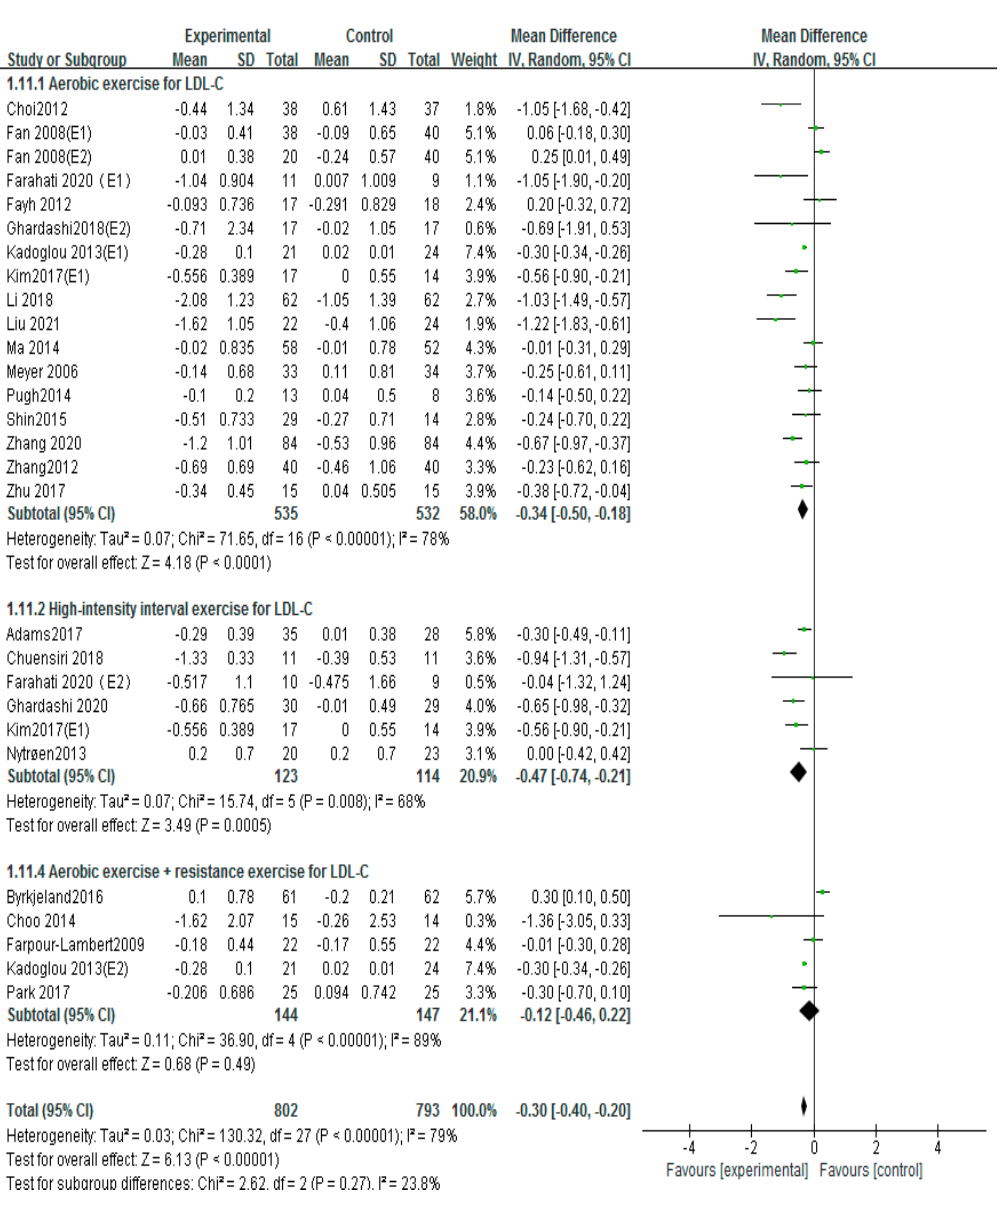
Figure 9. Subgroup analysis of LDL − C effect size under different modes of exercise [12,13,16–24,26–29,31,32,34–36,39,42,43,45].